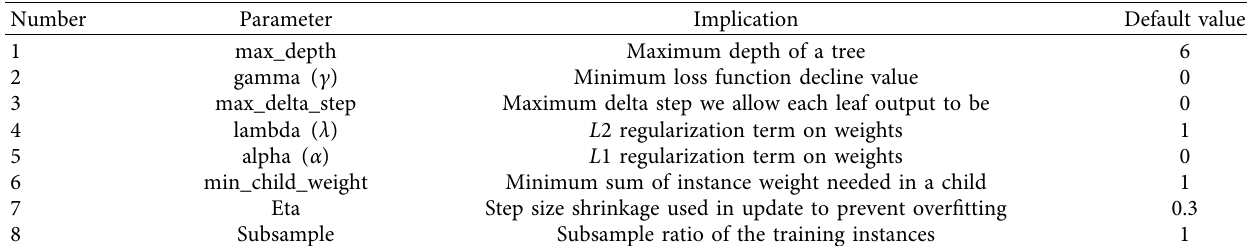
Table 3: Main parameters information of XGBoost